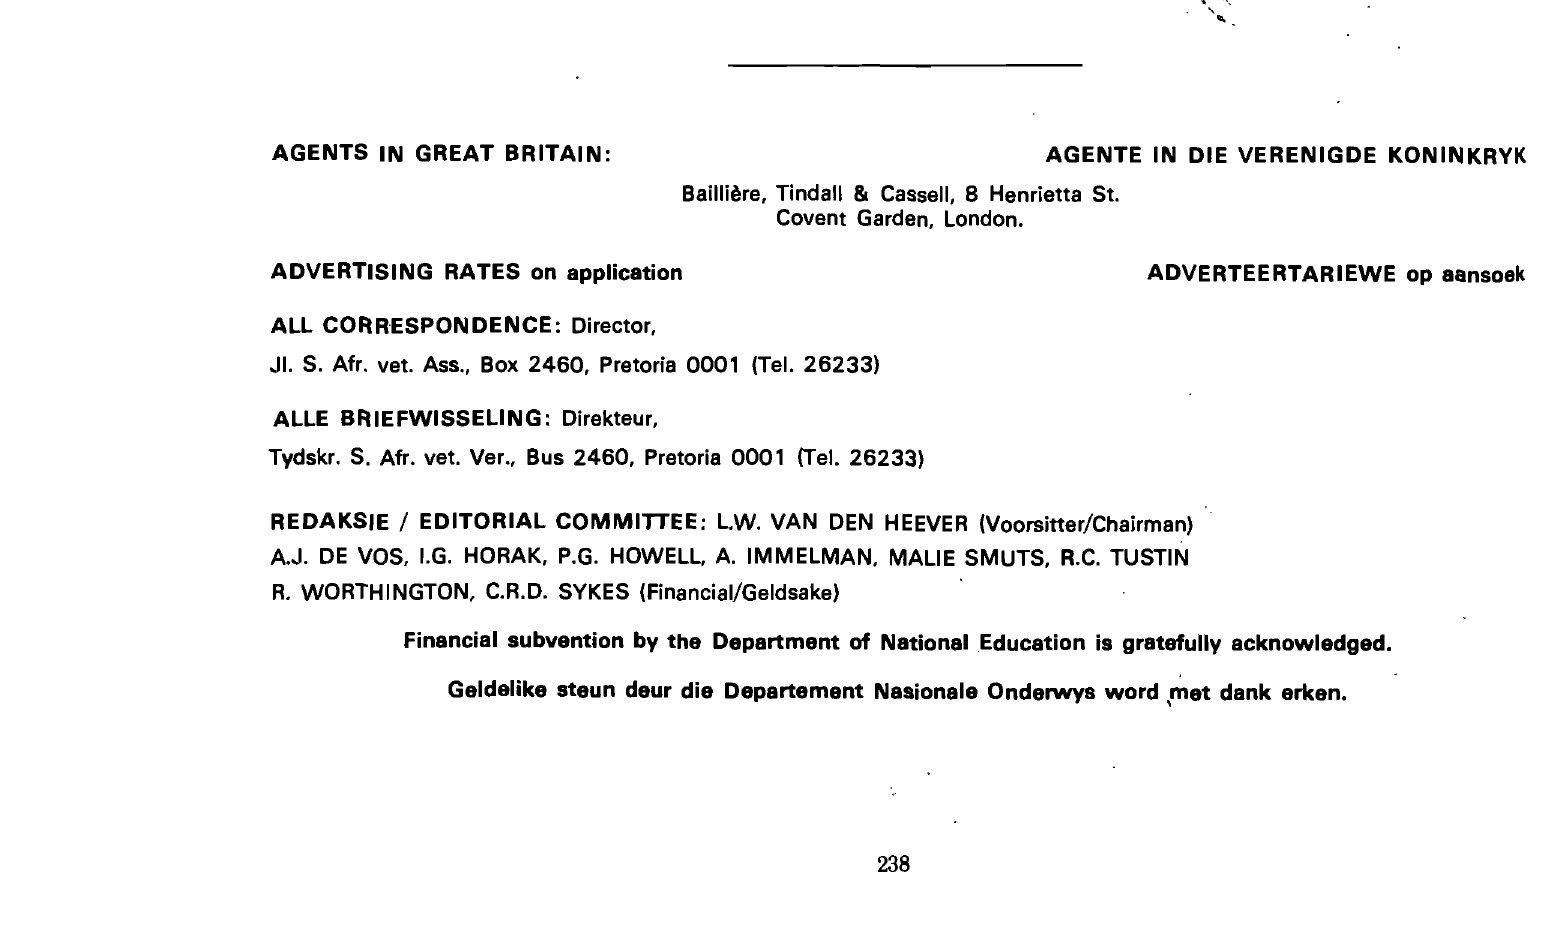
toegelaat.'TABELLE en FIGURE moetin breedtes van 8,5 cm, of17,75 cm, of in groottes van 26:25 x 17,75 Cffi'weergegee word, of daartoe gereduseer kan word. Die getal figure en tab~lle kan na oordeel 'Ian die Redaksie beperk word tensy die outeur tot die koste van reproduksie bydra, veral kleurreproduksie. HERbRUKKE moet ten tye van indiening van die bydrae bestel word. Senior outeurs kry 25